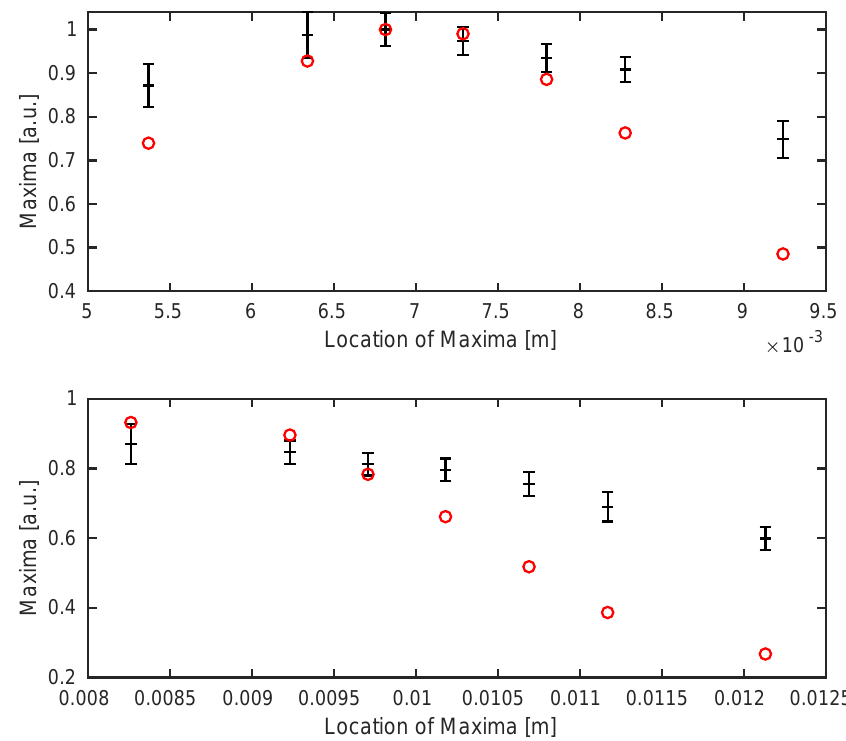
Figure 6. Comparison between the experimental data (black with errorbars) and the simulated (red) data points for calibrated values of w 0 and θ max . Top: we see the top boundary surface of the coverglass, bottom: the background